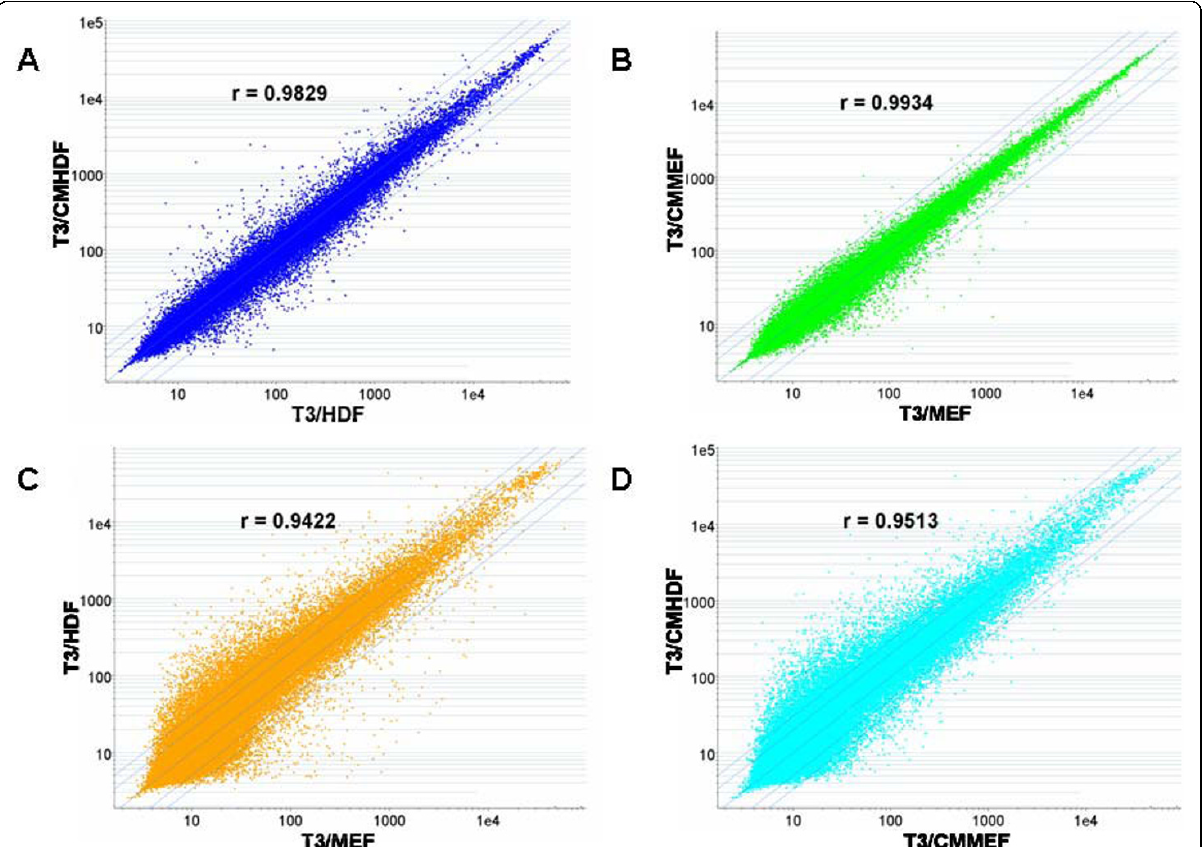
Figure 1 Scatter plots and correlation analyses of mRNAs among T3/HDF, T3/CMHDF, T3/MEF and T3/CMMEF cells . A. T3/HDF vs T3/ CMHDF; B. T3/MEF vs T3/CMMEF; C. T3/MEF vs T3/HDF; D. T3/CMMEF vs